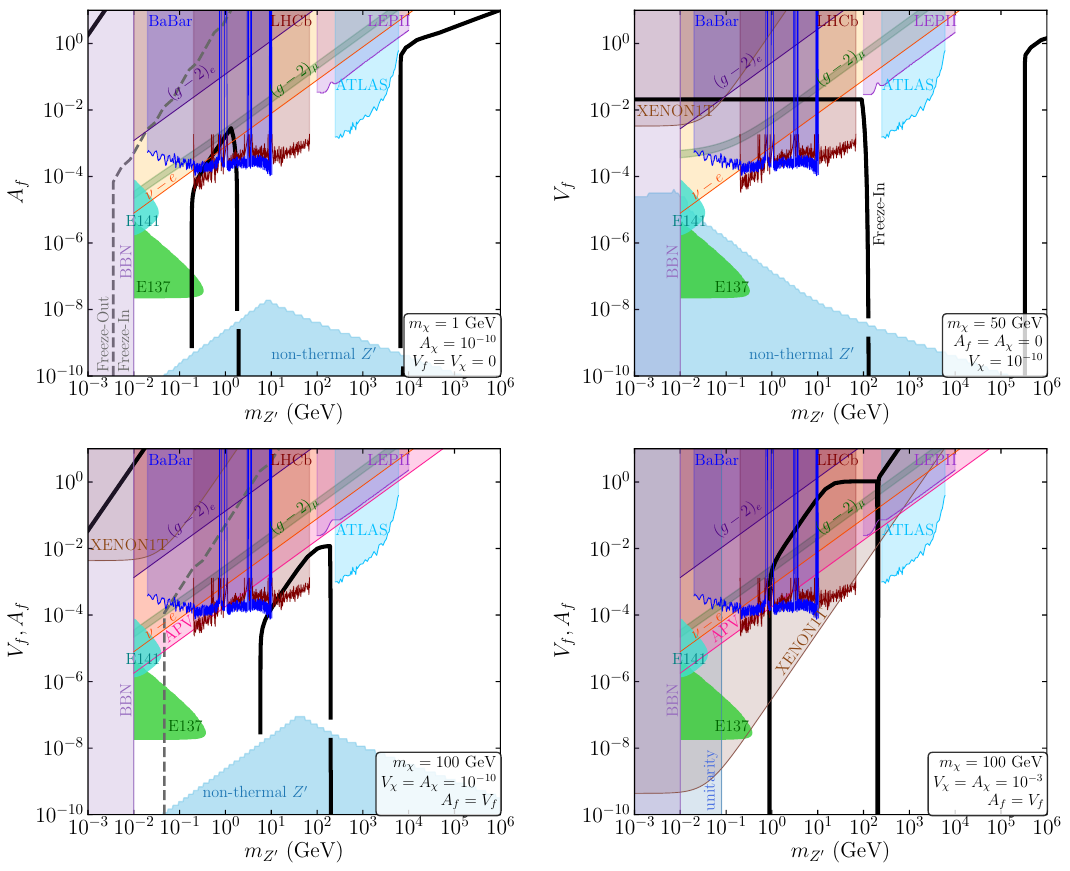
Figure 4. The relevant constraints (coloured shaded regions), each described in section 4, on the contours consistent with the observed DM abundance [1] (solid black curves), for both freeze- out and freeze-in mechanisms. The dashed grey curve corresponds to the regime boundary, with WIMPs (FIMPs) in the region to the left (right). In the region labeled as “non-thermal Z 0 ” (in light blue), the Z 0 was never thermalized with the SM particles. The panels on the top (bottom) right lack this regime boundary, hence in the entire plane DM is produced through freeze-in (freeze-out). The top left panel shows the scenario with purely axial couplings, for m χ = 1 GeV, whereas the top right panel illustrates the case with purely vector couplings, for m χ = 50 GeV. In the bottom panels, we present the scenario with both axial and vector couplings, for m χ = 100 GeV, where A χ = V χ = 10 − 10 on the left and A χ = V χ = 10 − 3 on the right.